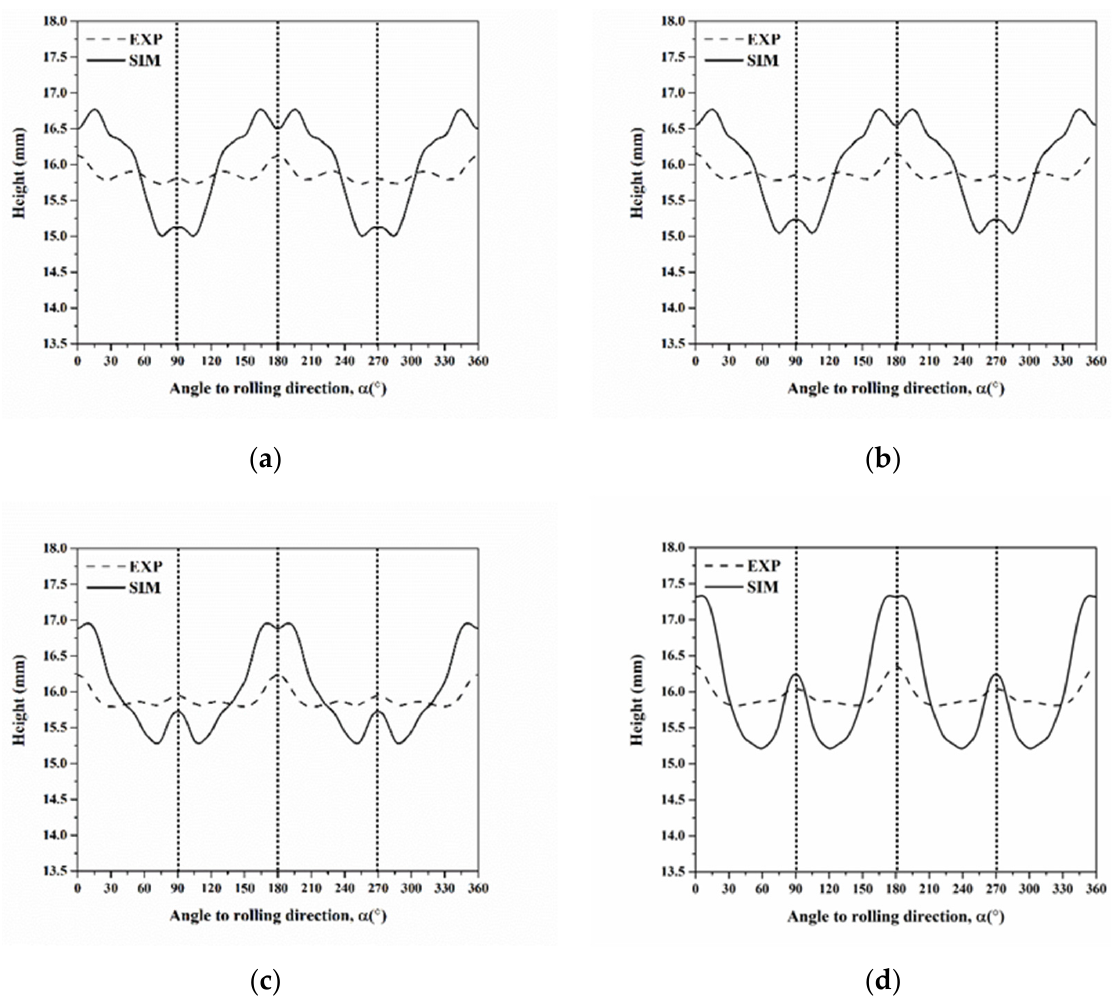
Figure 17. Cup height profiles as a function of the angle in AA5151 alloy at 250 °C for ( a ) 0.5, ( b ) 1, ( c ) 2, and ( d ) 3 h using six components considering the single slip system with orientation spread (Dashed and continuous lines mean experiment and a simulation, respectively).